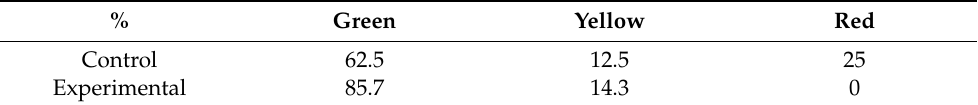
Table 9. Percentage of collective evidence depending on the error severity.